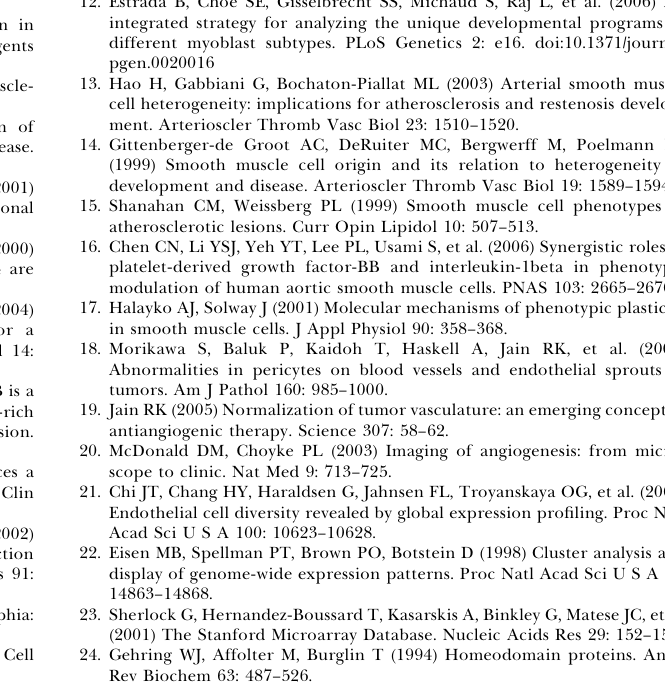
Table S1. Multivariate Analysis of Classical Prognostic Factors and SMC Serum-Response Signature Table S2. Gender and Age Distribution of SMC